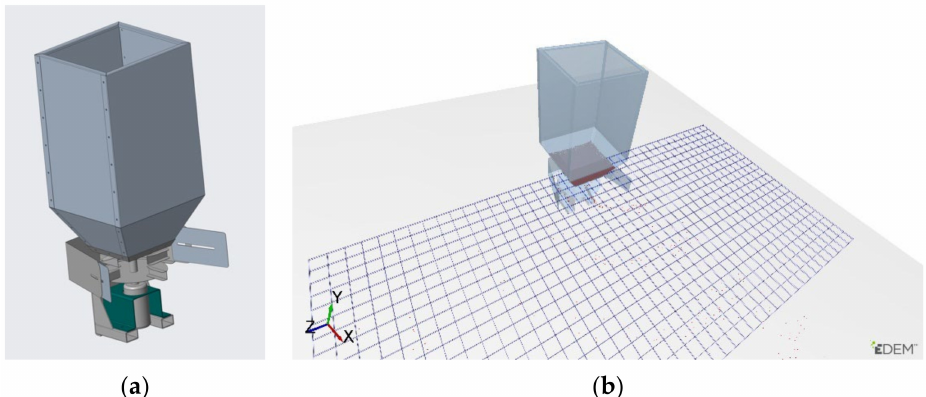
Figure 7. Assembly and simulation drawing of centrifugal disc spreader. ( a ) 3D model; ( b ) simulation model.